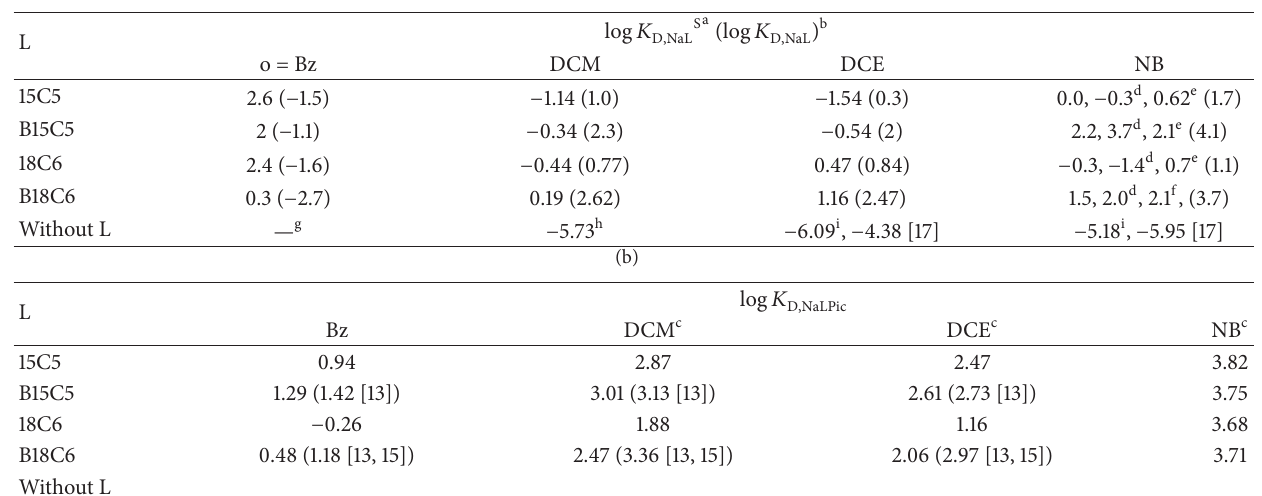
Table 2: Individual distribution constants of NaL + and NaL + Pic − into some diluents at 25 ∘ C.